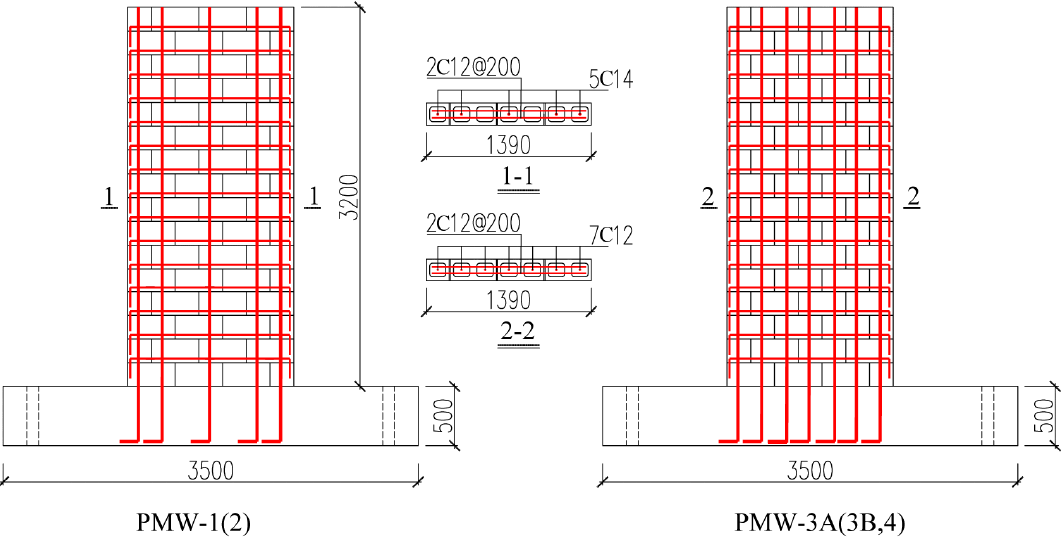
Figure 2. Design of test specimens (mm).